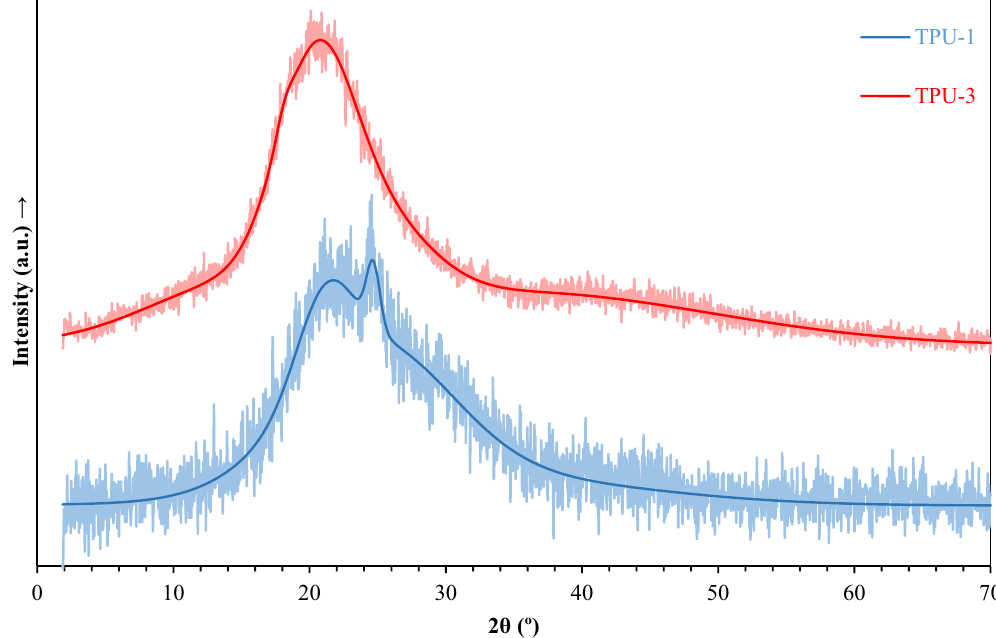
Figure 5. The XRD patterns of the TPU-1 (blue line) and TPU-3 (red line) and their model curves to discrete reflections at appropriate 2θ values.